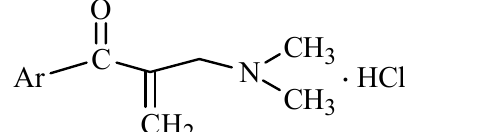
Figure 1. Chemical structures of the synthesized compounds 1-9